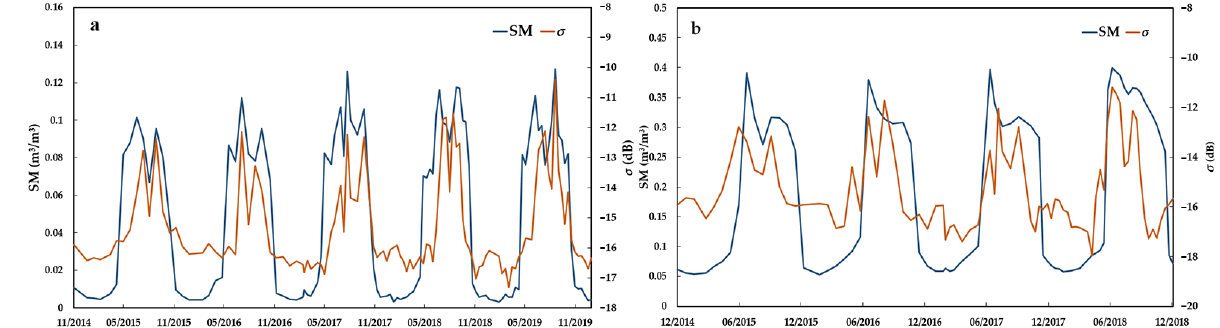
Figure 3. The time-series variation of SM and σ ° at sites. ( a ) QT08 and ( b ) QT09 .